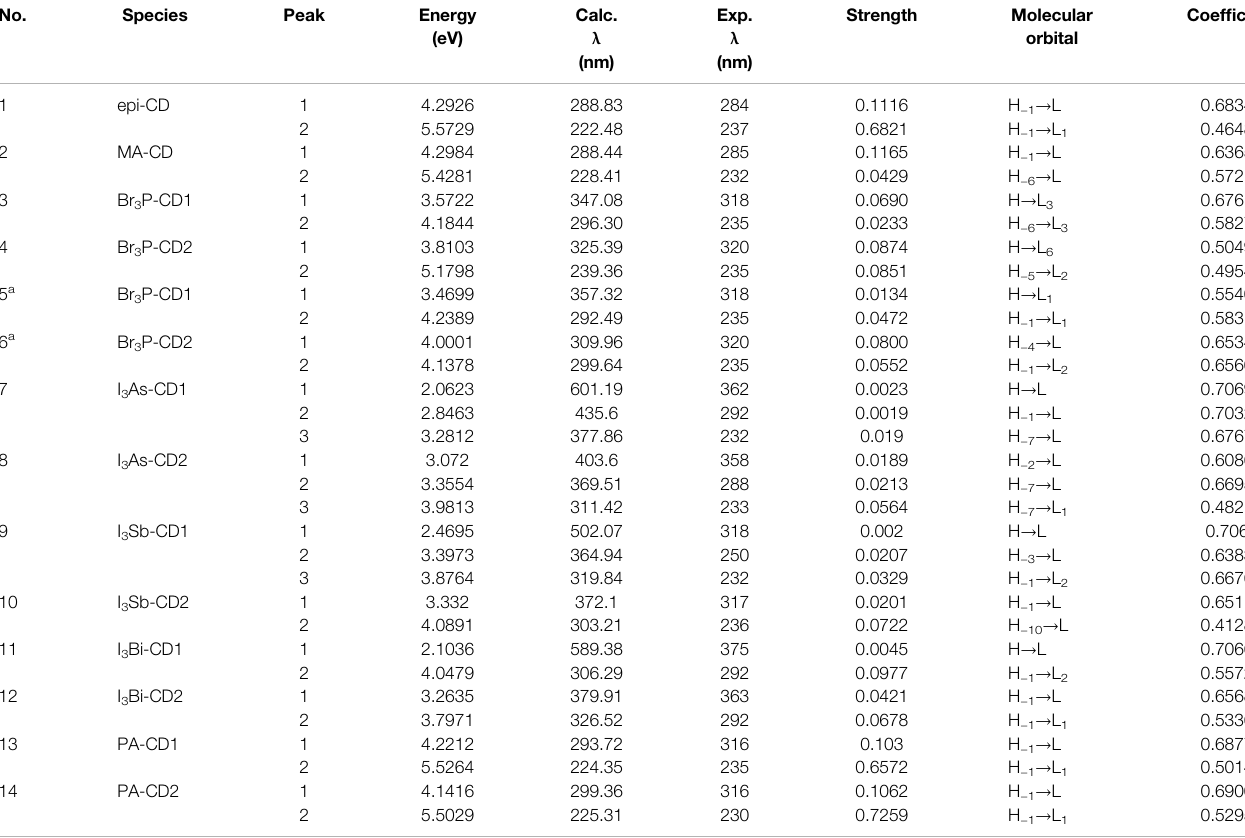
TABLE 6 | Calculated excitation energies, oscillator strengths, and molecular orbitals (MOs) of CD and CD-X at the TD-B3LYP/6-31+G(d,p) level of theory. No.